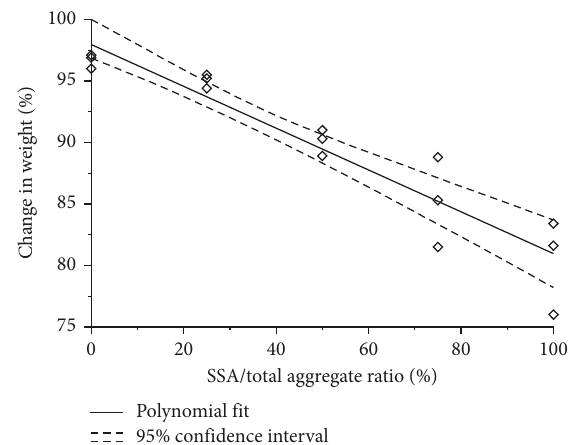
Figure 8: Relationship between the SSA replacement ratio and the change in weight in the column segregation